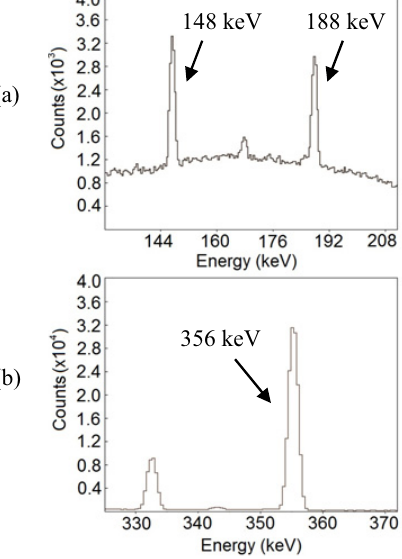
Figure 3. Typical off-line spectra of natural Au taken at incident neutron energy 17.1 MeV, where the gamma-ray peaks from the decay of the second isomeric state (a) and both ground and isomeric states (b) of 196 Au nucleus are presented. The acquisition time is 18.0 and 25.0 h, respectively. Table 1. Decay properties of the daughter nuclei